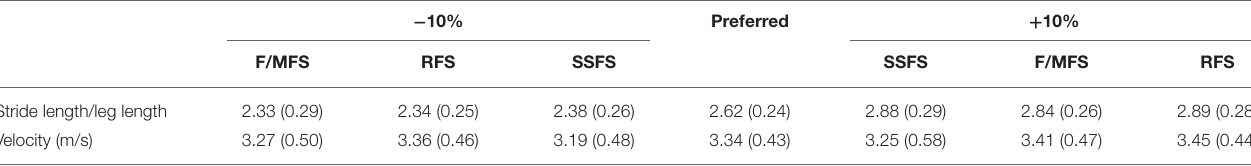
TABLE 1 | Stride length normalized by leg length and velocity for the preferred and manipulated stride length and foot strike trials. −